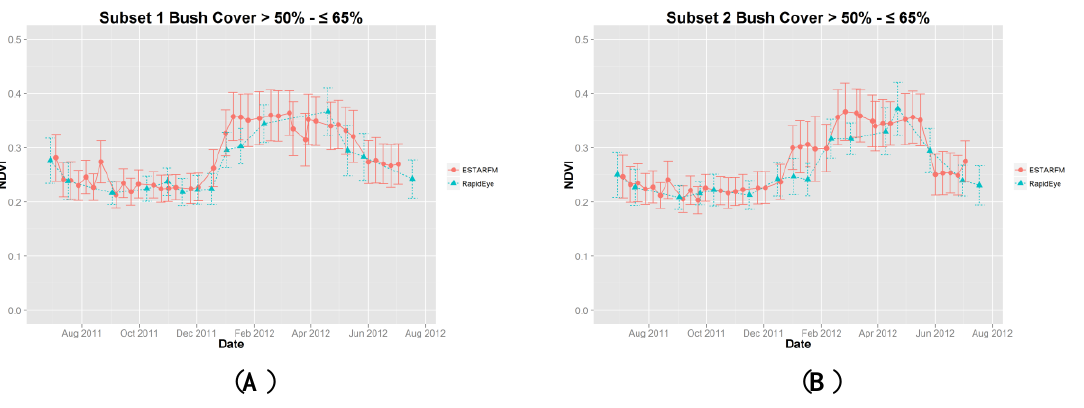
Figure 8. Time series of mean NDVI values calculated for all MODIS pixel size extents classified as containing >50% and ≤65% bush cover. See Figure 6 for detailed description of sub-plots. ( A ) subset 1; ( B ) subset